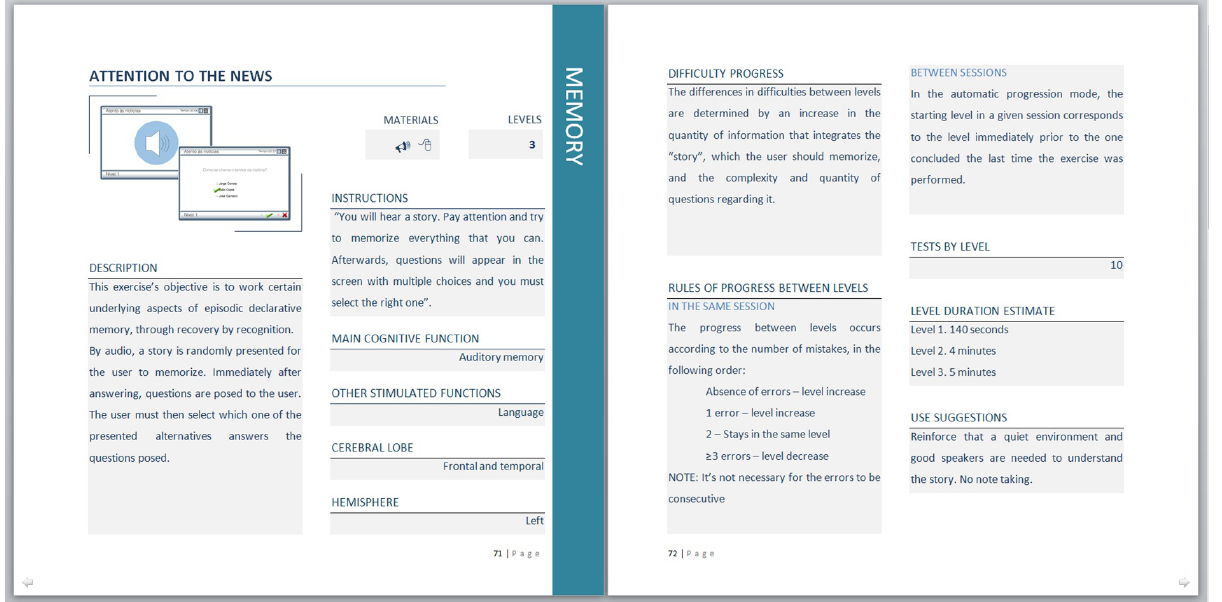
Figure 6. Example of an information sheet for the game exercise "Attention to the